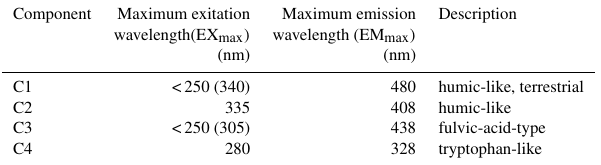
Table 1. Characteristics of PARAFAC components based on Fell- man et al. (2010).